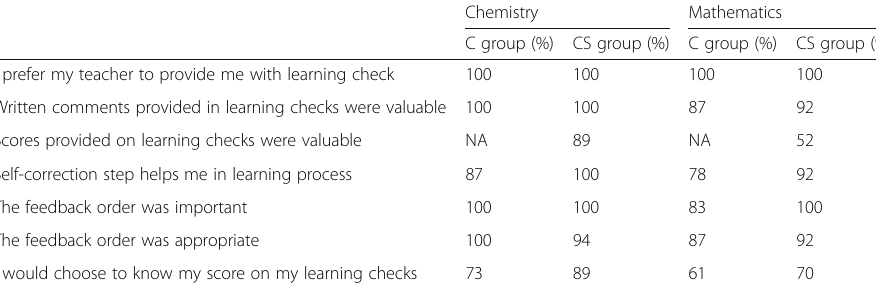
Table 4 Survey result for chemistry and